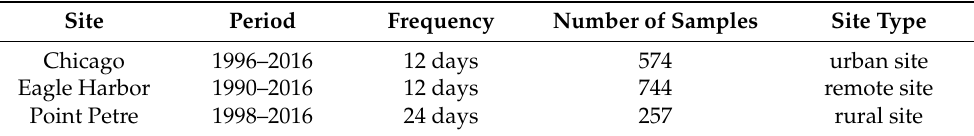
Figure 4. Visualization of original concentration values of Suite PCBs at seven monitoring stations in Great Lakes region. Table 1. Details of experimental